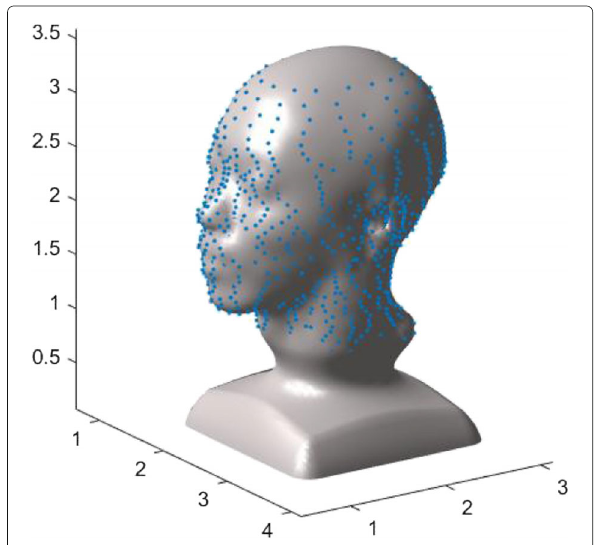
Fig. 14 Implicit shape designed by blending an implicit geometry with a real world object reconstructed by using an implicit fitting